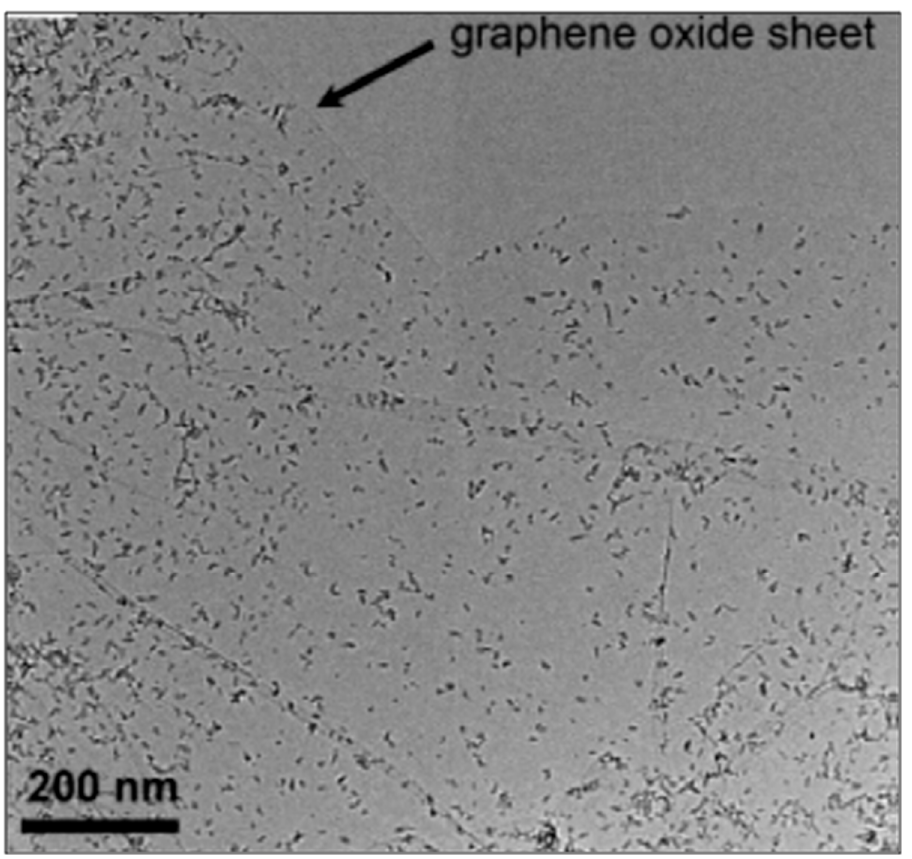
Figure 15. TEM image of TiO 2 /GO nanocomposite with low TiO 2 loading. Reprinted with permission from reference [141]. Copyright 2014 American Chemical Society.